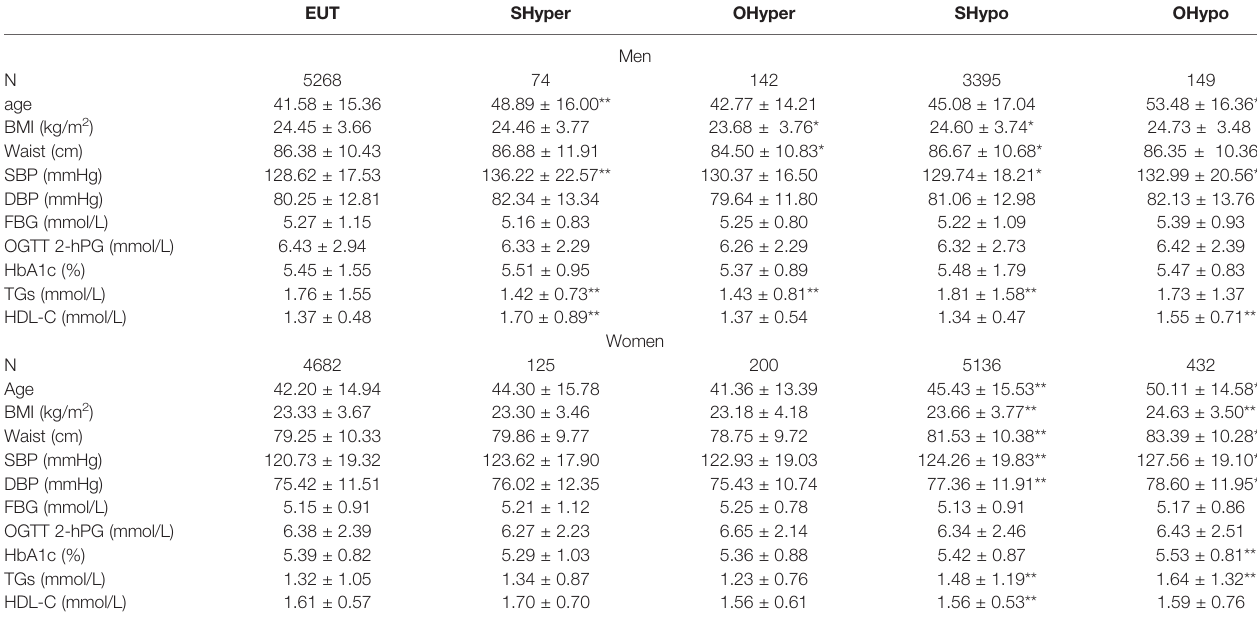
TABLE 2 | Metabolic differences in different thyroid functional states by